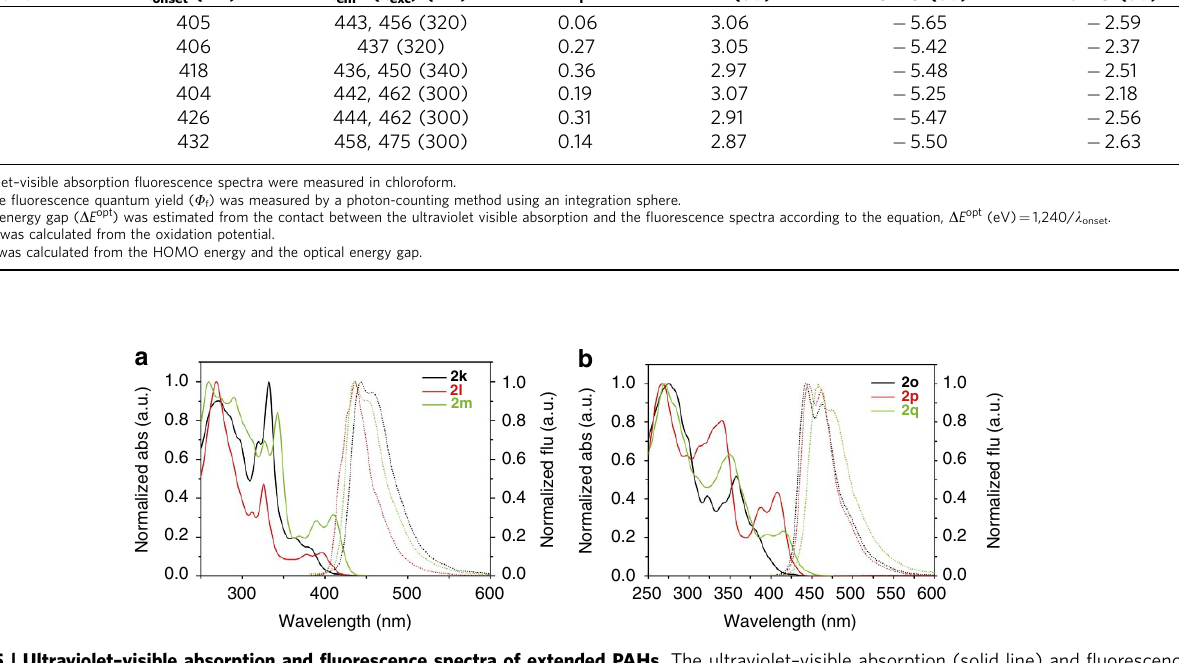
Figure 5 | Ultraviolet–visible absorption and fluorescence spectra of extended PAHs. The ultraviolet–visible absorption (solid line) and fluorescence spectra (dash line) of 2k – m ( a ), and 2o – q ( b ) in diluted chloroform. The ultraviolet–visible absorption red-shifted as expending their p -conjugation lengths. The extended PAHs possess relatively large Stock shifts, indicating their weak structural rigidity.